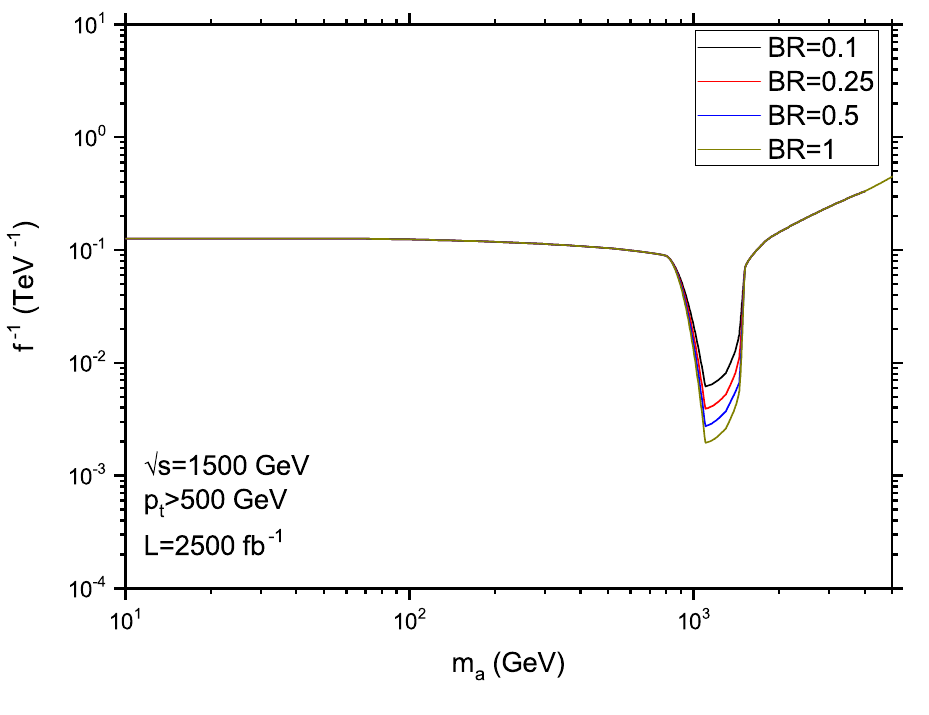
Figure 12 . The 95% C.L. CLIC exclusion region for the process e + e − e + γγe − with the invariant energy √ s = 1500 GeV, transverse momentum cut on the final photons p t = 500 GeV, integrated luminosity L = 2500 fb − 1 , and different values of Br( a for the initial photons in the subprocess γγ